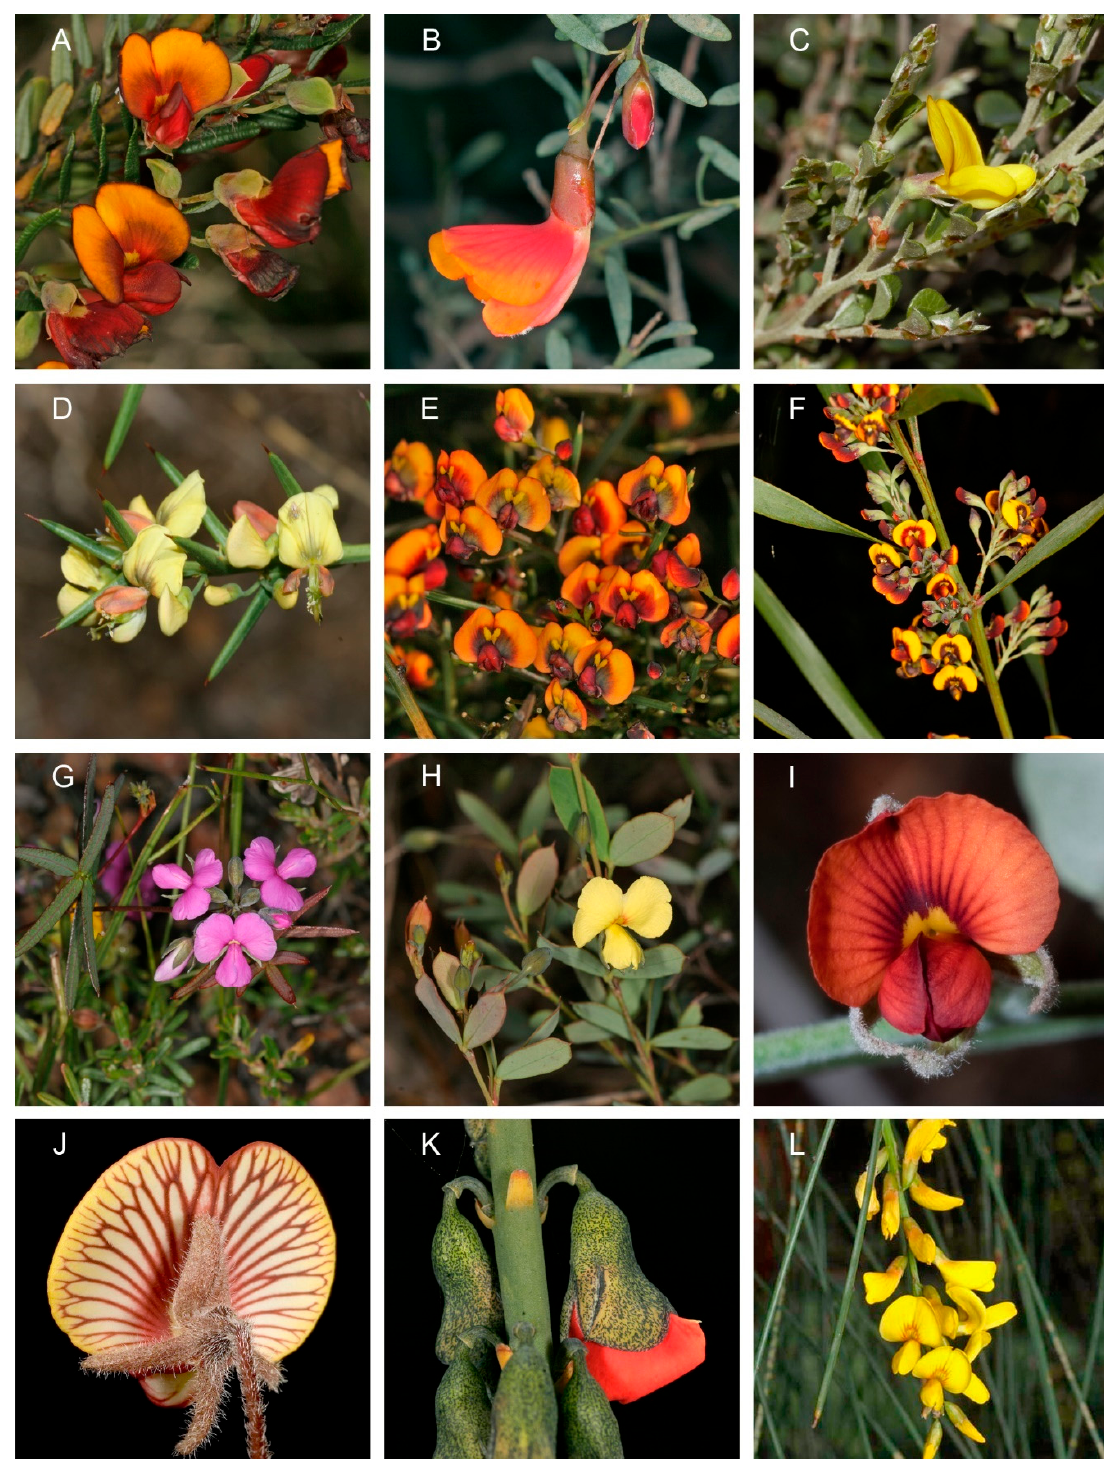
Figure 2. Morphological diversity of representative species from Fabaceae tribe Bossiaeeae (sister to Mirbelieae) and non-core Mirbelieae. ( A ) Bossiaea eriocarpa . ( B ) Bossiaea preissii . ( C ) Bossiaea sericea . ( D ) Daviesia angulata . ( E ) Daviesia hakeoides . ( F ) Daviesia mimosoides subsp . mimosoides . ( G ) Gompholobium knightianum . ( H ) Gompholobium marginatum . ( I ) Isotropis atropurpurea . ( J ) Isotropis cuneifolia subsp . cuneifolia (calyx and rear face of corolla). ( K ) Sphaerolobium drummondii . ( L ) Viminaria juncea . Photographs by Russell Barrett except ( J ) by Kevin Thiele and ( L ) by Murray Fagg from the Australian Plant Image Index: http://www.anbg.gov.au/photo (accessed on 11 June